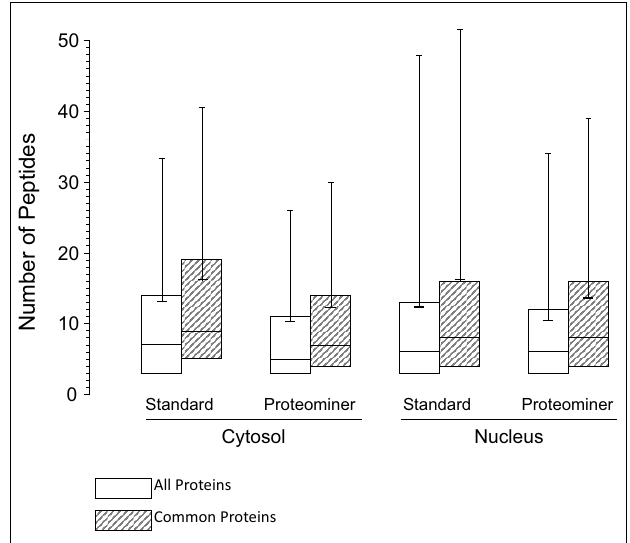
FIGURE 7 | Box plots of number of peptides identified under each experimental condition. The box encompasses the upper and lower quartile. Median values for each condition are indicated by the full horizontal line inside each box, the average is indicated by the shorter thick line, and SDs are indicated by upward error bars , all identified proteins; , only proteins identified as common to both the standard and PM